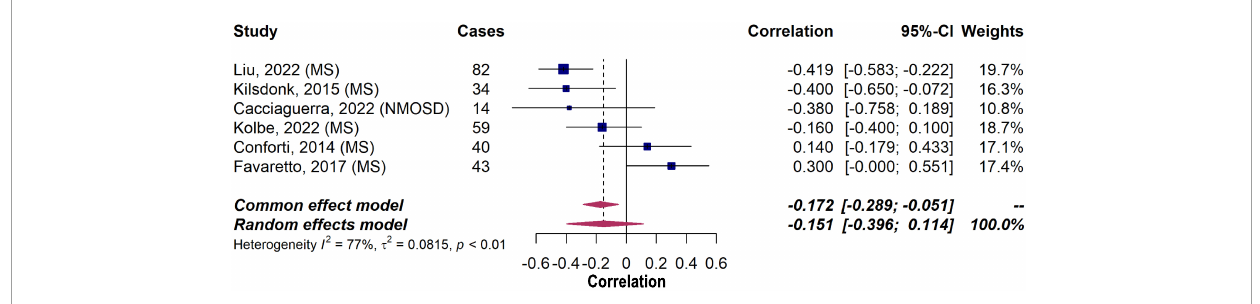
FIGURE4 Forest plot of correlation coefficients between MRI-visible perivascular spaces (MVPVS) and brain volume measures. Pooled analyses of studies comparing the correlation between MVPVS and brain volume measures shows no statistically significant correlation (a negative correlation indicates that higher MVPVS levels correlate with lower brain volume measures). Correlation coefficients were extracted and pooled using the random effects DerSimonian-Laird method. CI, confidence interval; MS, multiple sclerosis; NMOSD, neuromyelitis optica spectrum